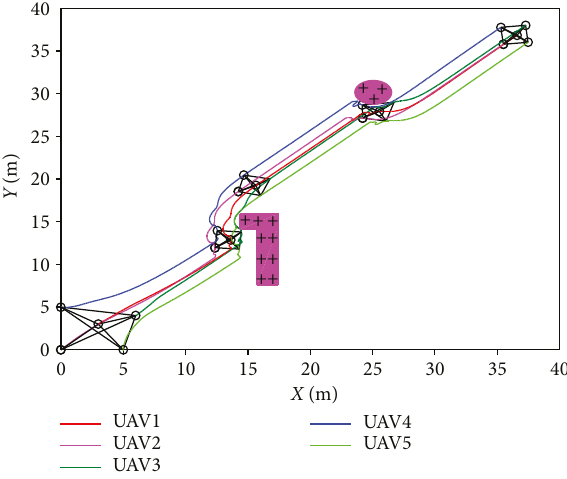
Figure 15: The trajectories of the consensus